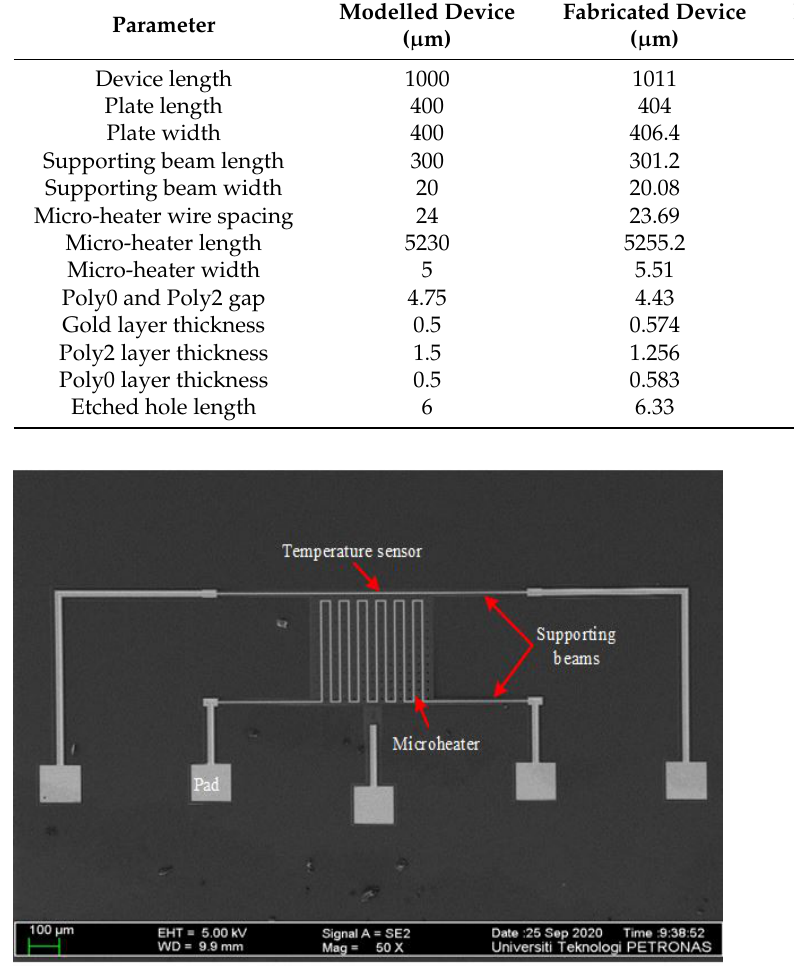
Figure 6. FESEM of the PolyMUMPs sensor showing measured plate parameters.